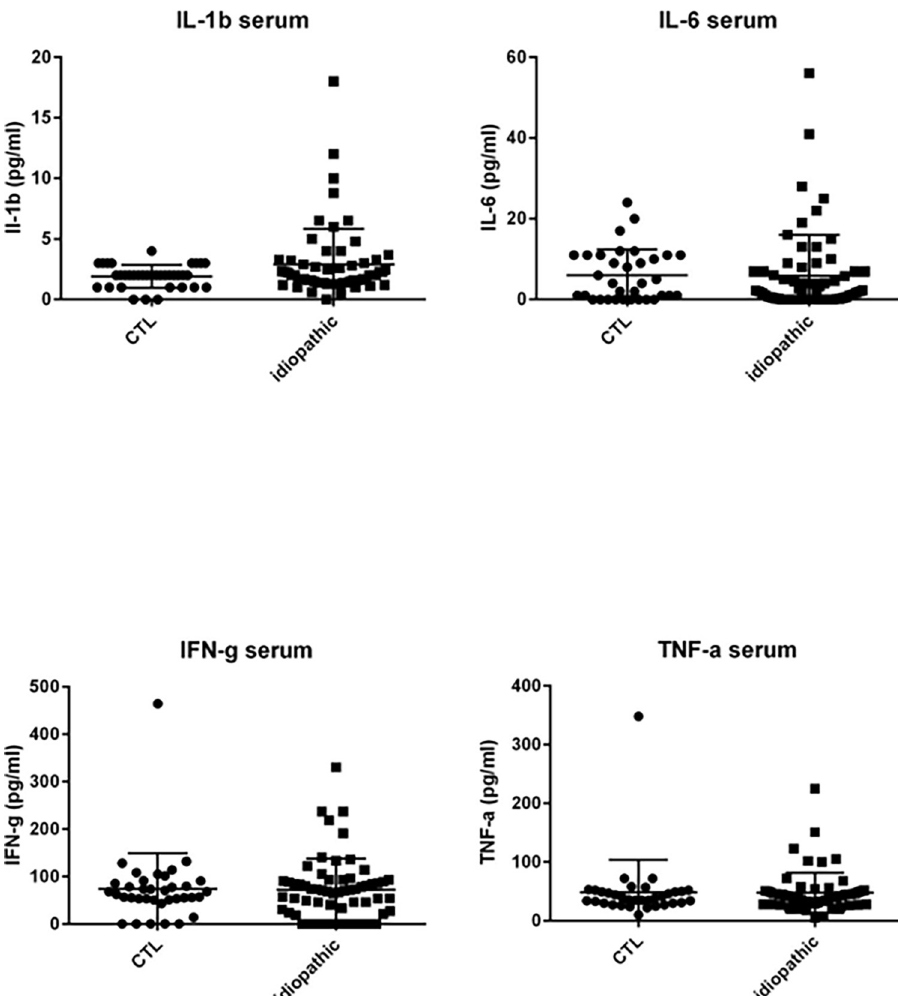
Fig 2. Dot plots of immune mediators, IL-1 β , IL-6, IFN- γ and TNF- α . IL-1 β , IL-6, IFN- γ and TNF- α in serum of noninflammatory controls patients (cataract age-related) (CTL) (N = 36) as compared with immune mediators in the serum of patients with idiopathic uveitis (n = 51) but differences in both groups are not significant. Note that few isolated patients with idiopathic uveitis had cytokines increased in serum samples. � = P < 0.05 ; �� = P < 0.01; ��� = P <